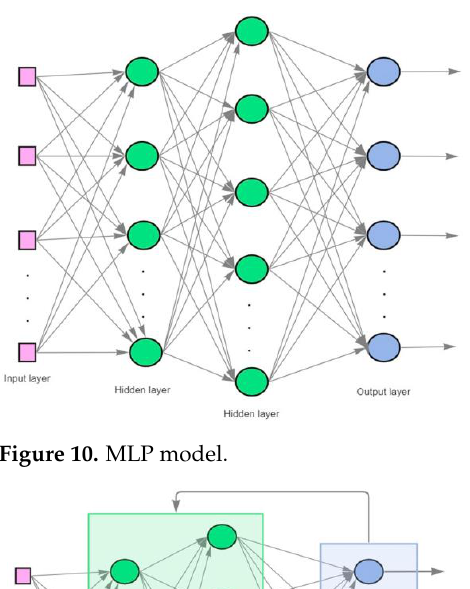
Figure 10. MLP model.